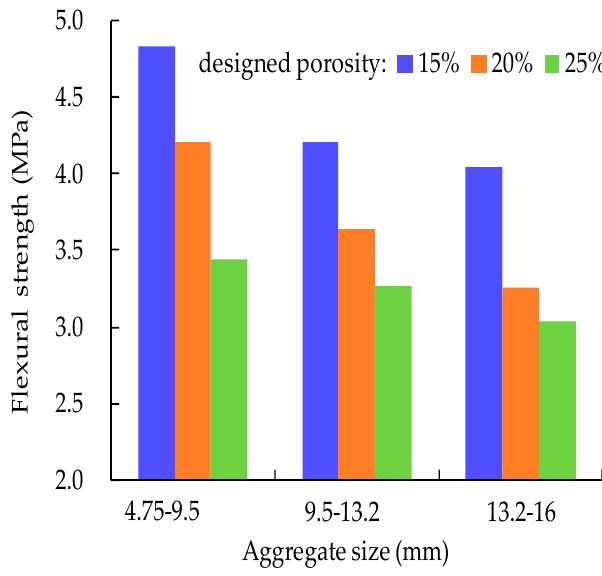
Figure 12. Relationship between flexural strength, designed porosity and aggregate size.